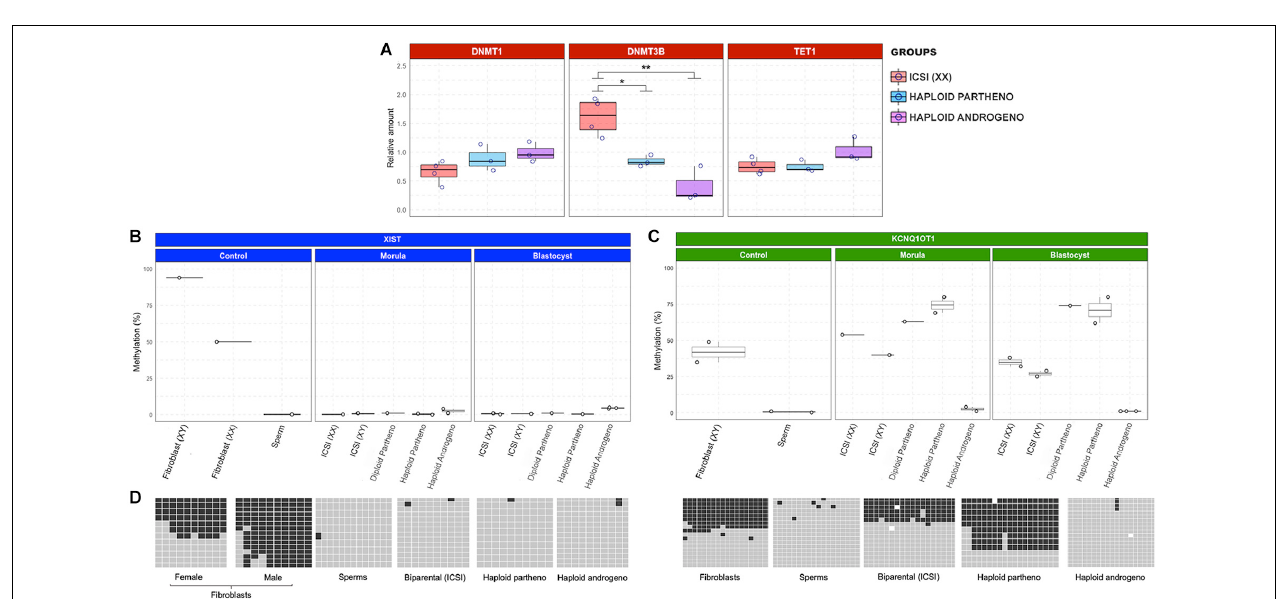
FIGURE 8 | Relative transcript levels of different imprinted and X chromosome-linked genes on haploid and diploid morula stage embryos obtained by ICSI, parthenogenetic activation or ICSI + enucleation. Blue boxes: X-linked genes XIST, PGK1, and HPRT on X chromosome; green boxes: genes on the KNCQ1 locus KCNQ1OT1, CDKN1 and PHLDA2. GAPDH, ACTB, and SF3A were used as housekeeping genes for normalization. ∗ p < 0.05, ∗∗ p < 0.01, ∗∗∗ p < 0.001, ∗∗∗∗ p < 0.0001.